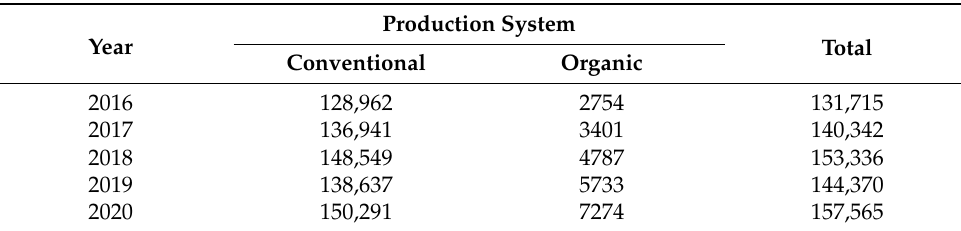
Table 1. Goat-milk production (1000 kg) according to the production system (years 2016–2020) (Hellenic Agricultural Organization—Demeter, 2021; personal